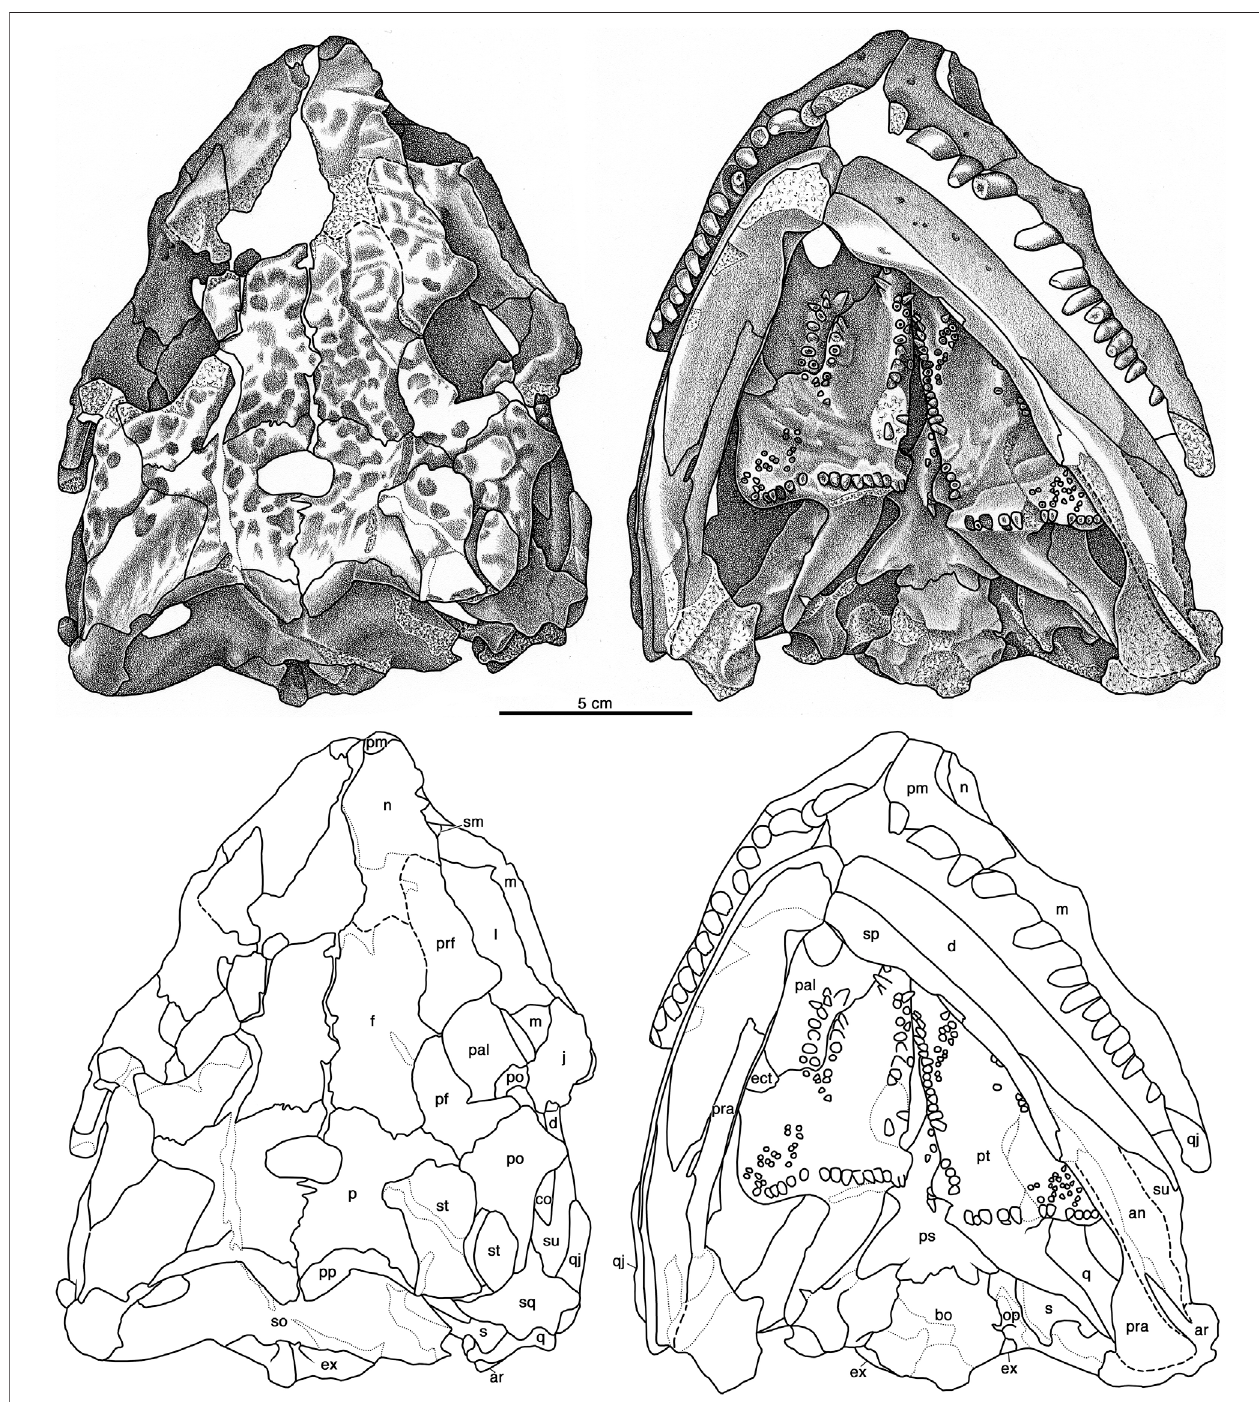
FIGURE 8 | Cotylorhynchus romeri , OMNH 04329, referred specimen. Dorsal and ventral views of skull. Abbreviations as in Figure 6 .